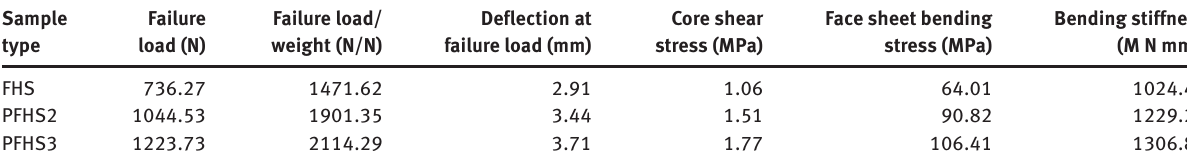
Table 4: The experimental results of FHS and PFHS sandwich panels subjected to flexural tests. Sample